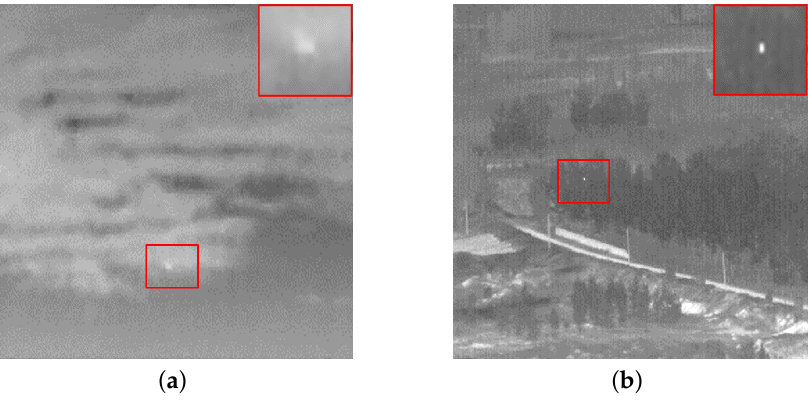
Figure 1. The typical infrared images; ( a , b ) are infrared images in two different complex